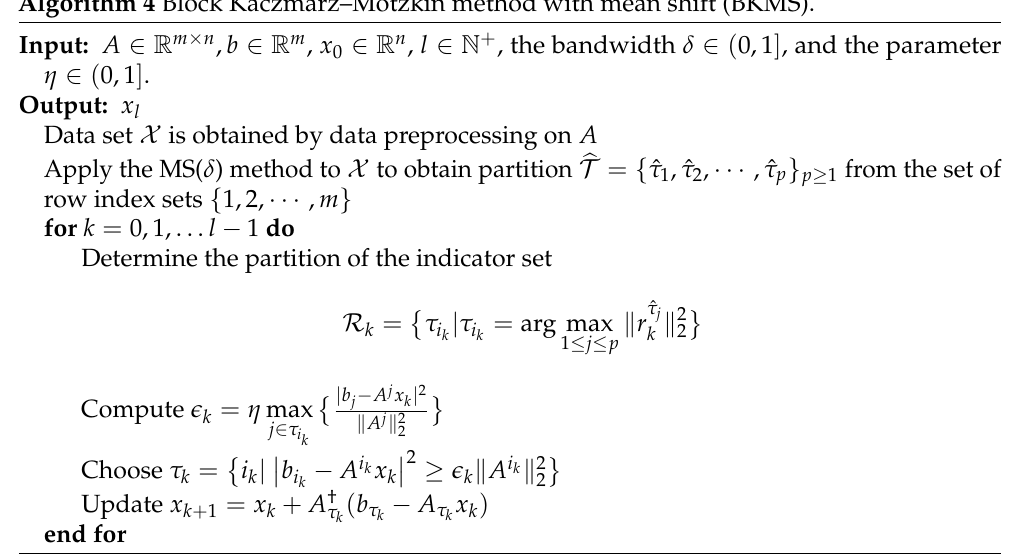
Algorithm 4 Block Kaczmarz–Motzkin method with mean shift